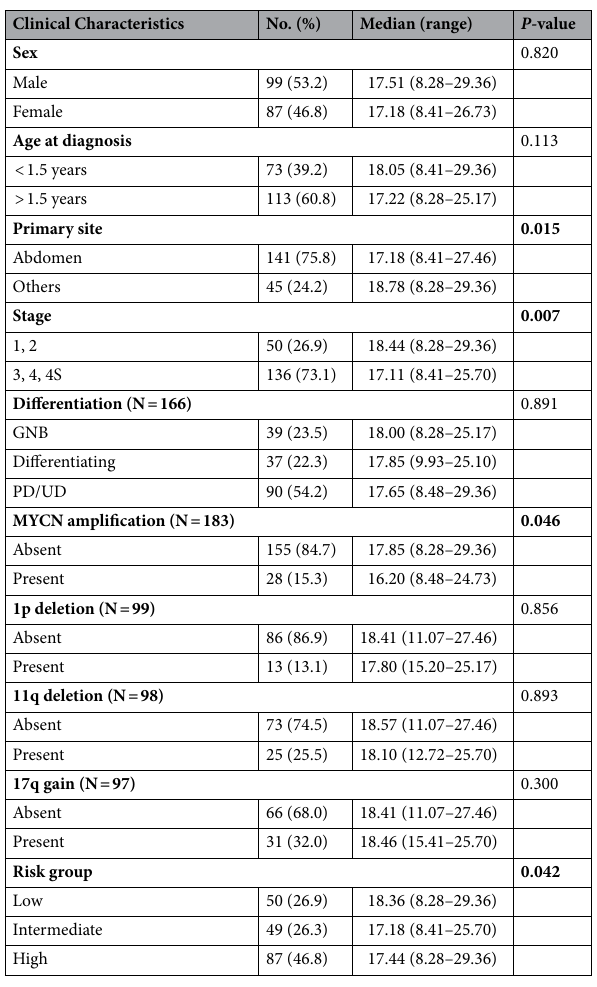
Table 1. Germline telomere length according to clinical characteristics. Abbreviations: Ganglioneuroblastoma (GNB), poorly differentiated (PD), undifferentiated (UD). Stage 1, 2, and 4S tumors were stratified into the low-risk group if MYCN was not amplified, whereas stage 4 tumors in patients older than 12 months (until 2008) or 18 months (since 2009) or any tumors with amplified MYCN were classified as the high-risk group. The intermediate-risk group includes all other tumors not mentioned